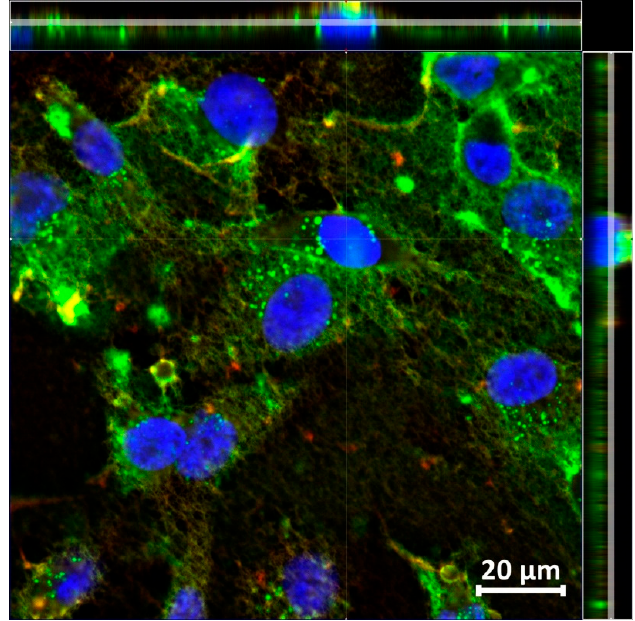
Figure 7. A 3D image of MDA-MB-231 cells incubated with modified M13-FAM bacteriophages (4 mM), Ortho image. Top-right—Z-axis images. Confocal microscopy was performed using the system: primary antibodies to the pVIII protein of the M13 phage and secondary antibodies to mouse IgG (H + L) conjugated to Alexa Fluor 647 (red channel, 633 nm). For visualization, nuclei were stained with DAPI (blue channel, 405 nm). The green channel, 488 nm, corresponds to the modified M13-FAM bacteriophage. Lens 63 × /1.40 Oil DIC M27.